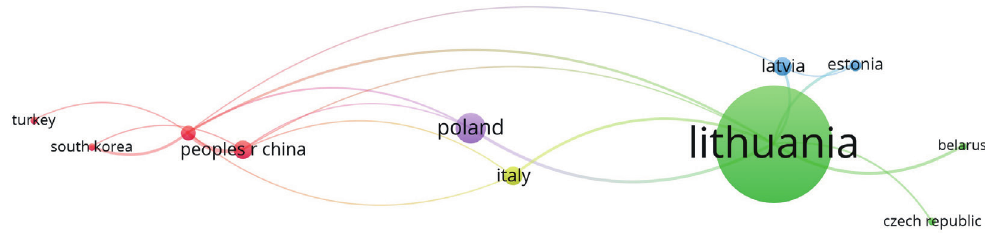
Figure 4. Country co-authorship network of the BJRBE